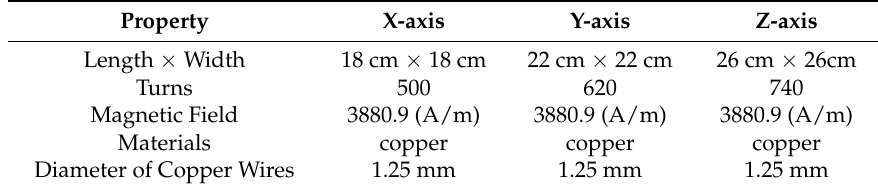
Table 2. Specifications of the three-axis Helmholtz coils.